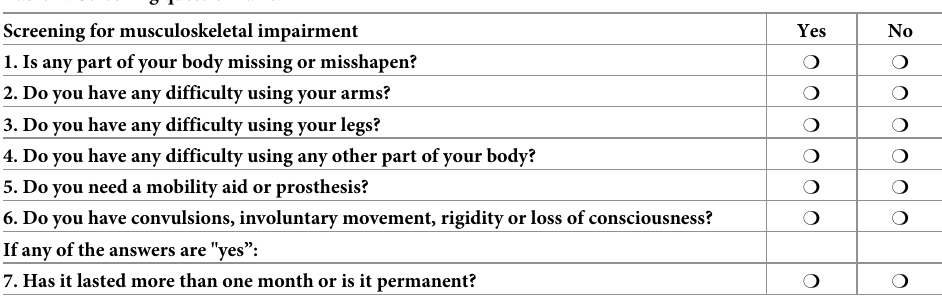
Table 1. Screening